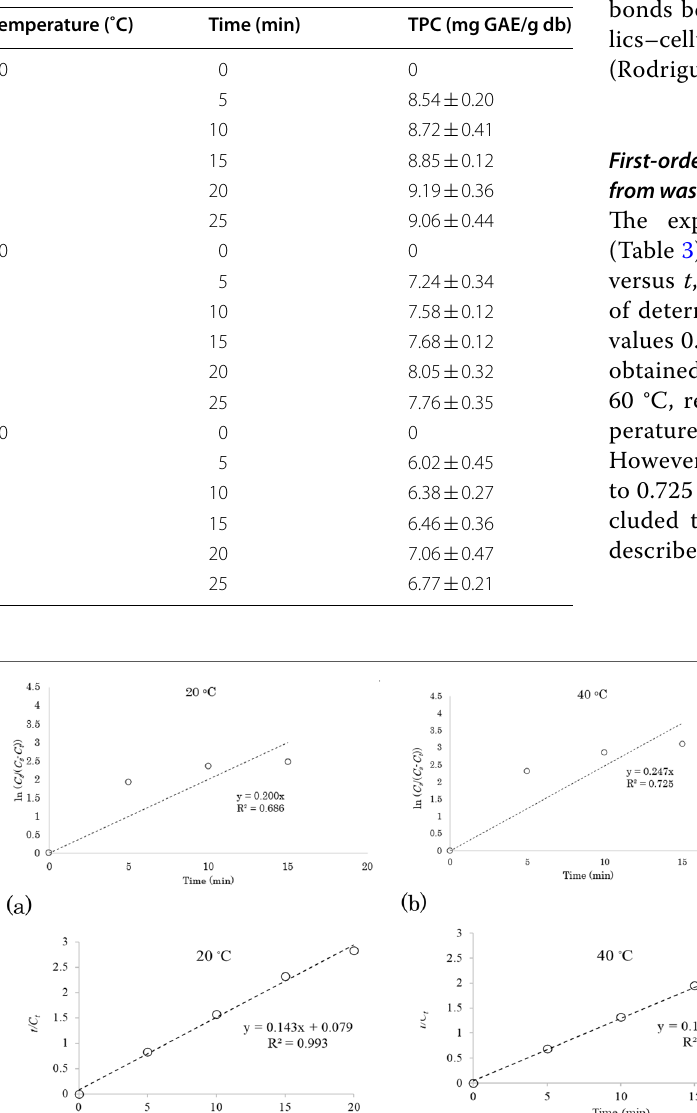
Table 3 Total polyphenolic compound (TPC) from apple pomace with 50 ETH at solid/solvent ratio of 1:80 g/mL, under continuous magnetic stirring at 200 rpm